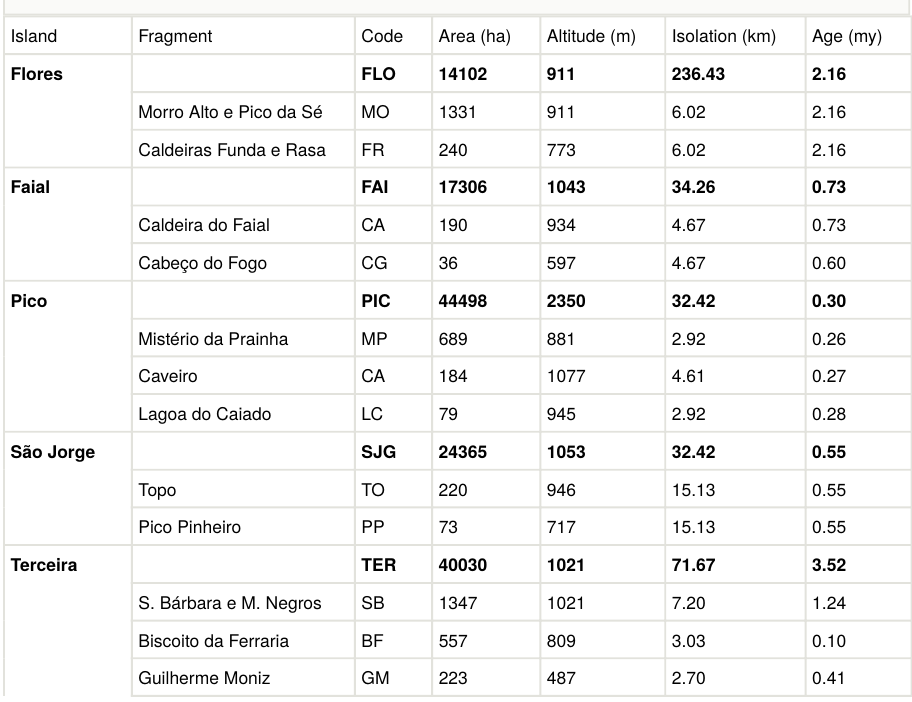
were sampled using a beating tray. Pitfall traps consisted of plastic cups with 4.2 cm were fi lled with a non-attractive ethylene glycol preservative solution (antifreeze solution), and the remaining with a general attractive solution, a modi fi ed version of Turquin (Turquin 1973) prepared mainly with dark beer and preservative agents. A few drops of dishwashing liquid were added to both solutions to reduce surface tension. Traps were sunk in the soil (cup rim at surface level) every 5 m along the transects, those fi lled with Turquin alternating with traps containing antifreeze solution. Traps were protected from rain using a plastic plate, placed about 5 cm above surface level and fi xed to the ground by two pieces of wire. Accidental collection of small vertebrates and damage by rodents was prevented using a piece of plastic mesh placed on top of the trap and fi xed to the ground by pieces of wire. The traps remained active in the fi eld for two weeks. Table 1. Main characteristics of the Azorean islands (bold) and native forest fragments sampled from 1999 to 2011, including area (hectares), highest point (altitude in metres), distance to the nearest island/ fragment (isolation in kilometres) and the oldest geological age of emerged substrate (million years BP) (adapted from Gaspar et al.